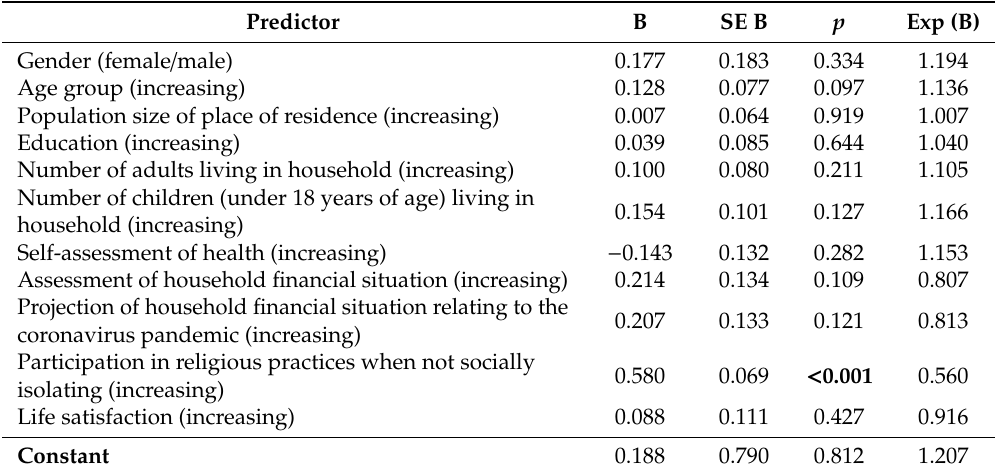
Table 1. Summary of a logistic regression analysis predicting increased religious involvement during the period of the Polish government’s strictest